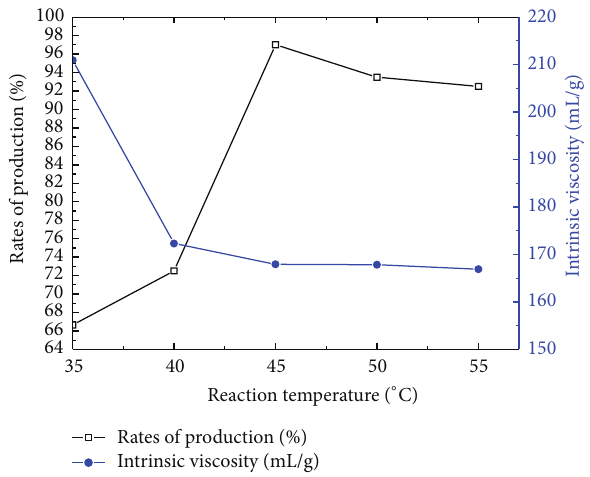
Figure 11: Effects of reaction temperature on intrinsic viscosity and rates of production.